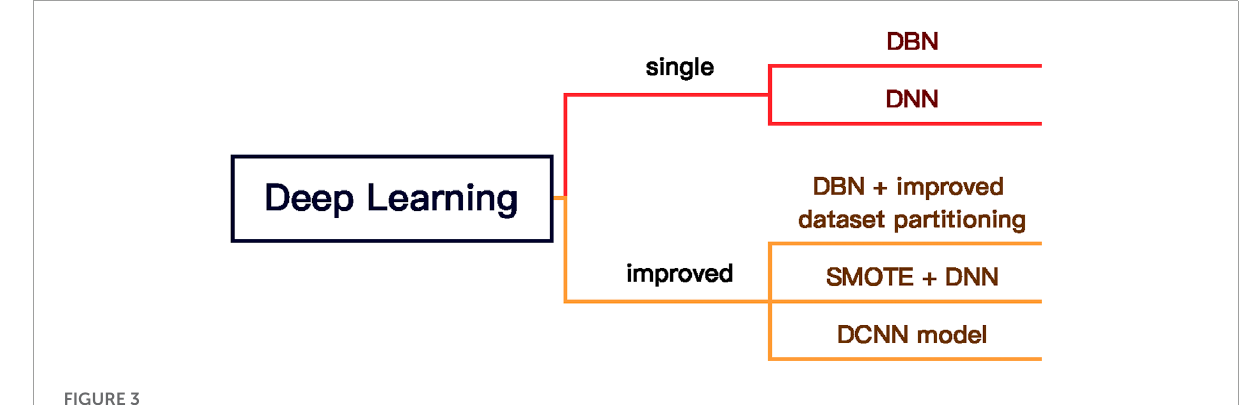
FIGURE 3 Deep learning-based fault dignosis methods.